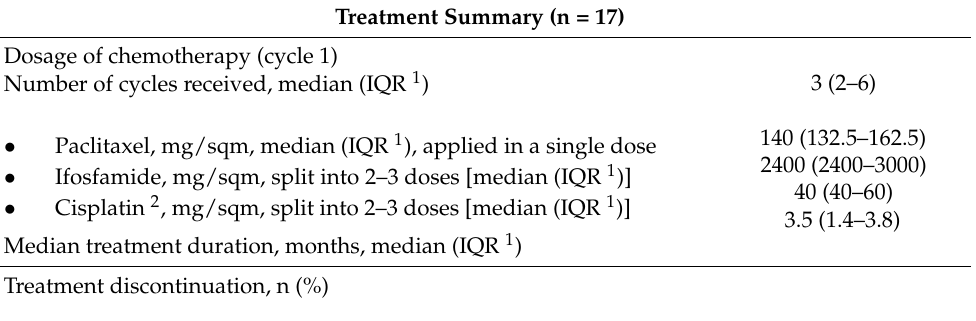
Table 2. Clinical results of mCRPC patients treated with TIP. Treatment Summary (n =